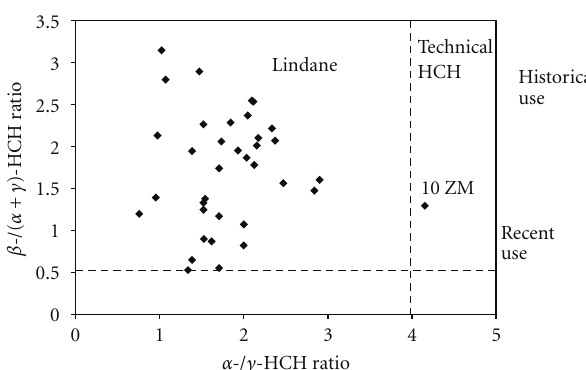
Figure 6: The identification of HCHs sources in the water from Lake